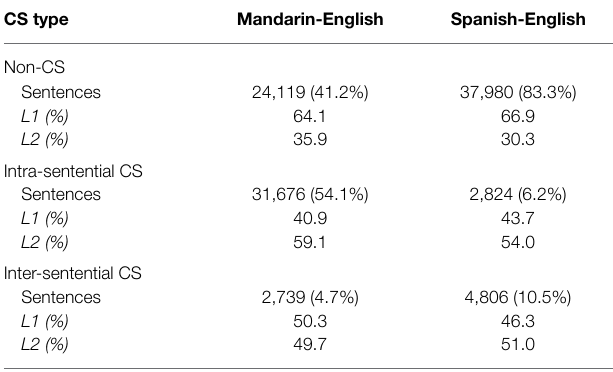
TABLE 2 | Frequencies and percentages of sentences and word tokens of the three CS types in bilingual